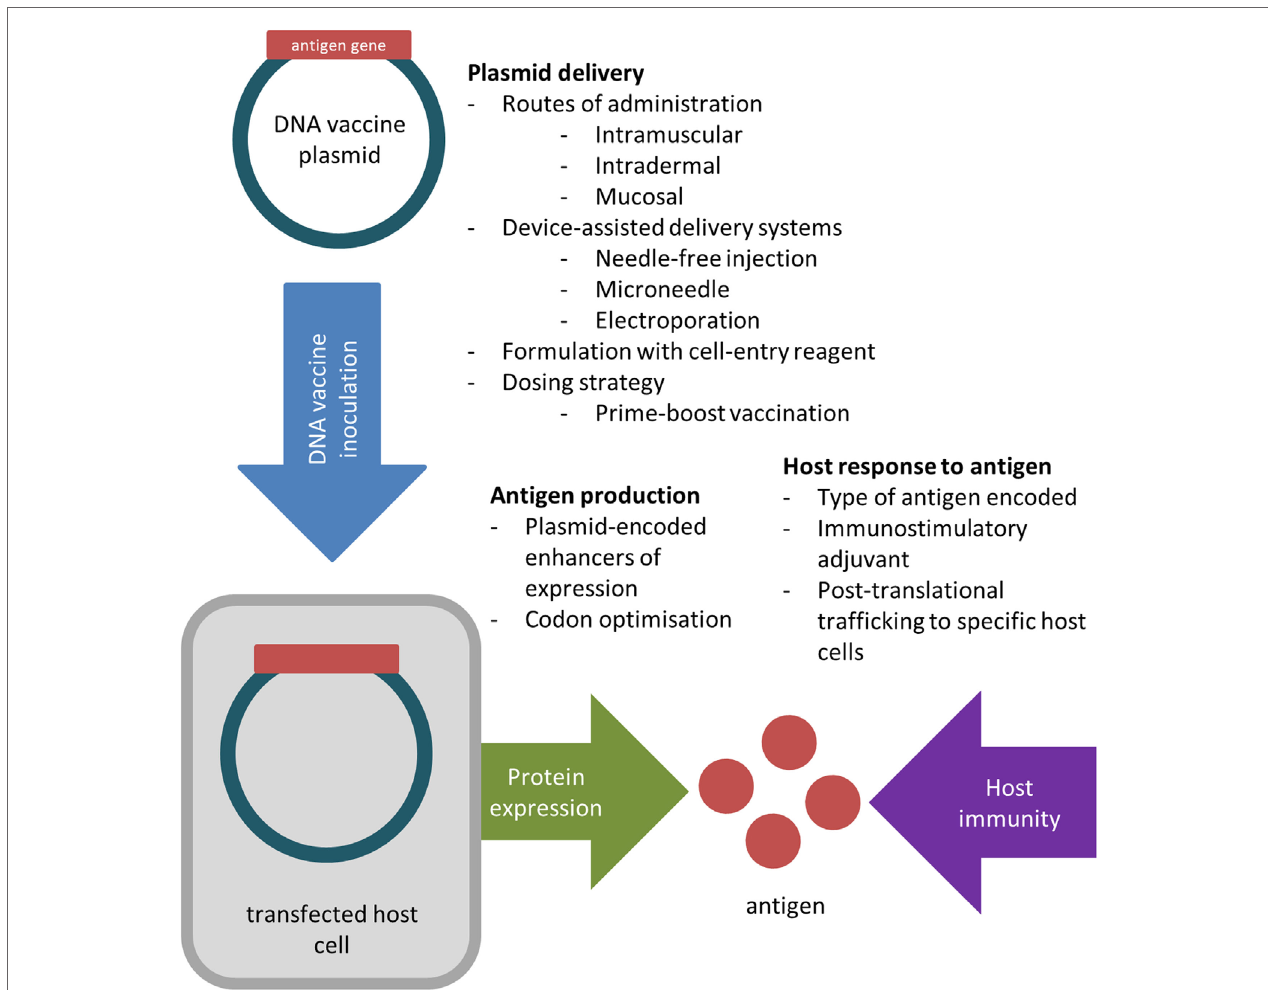
FigURe 1 | Key factors considered in the design, formulation, and inoculation of DNA vaccines to improve in vivo transfection efficiency and antigen immunogenicity.